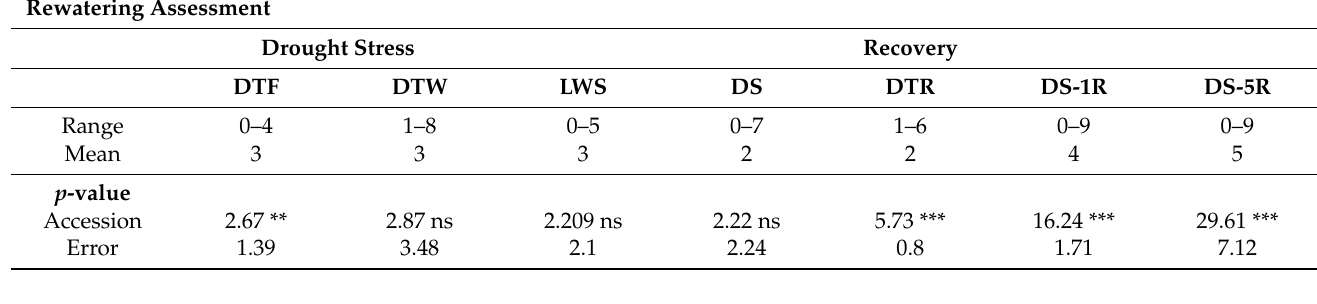
Table 6. Mean and the analysis of variance of days to the early panicle flowering (DTF), days to wilting (DTW), leaf wilting scoring (LWS), drought stress symptoms scoring (DS) and effects of rewatering on the days to recover (DTR) and DS at first and fifth day of recovery (DS-1R, DS-5R, respectively) in 44 A. tricolor accessions. Data represent range, mean, mean square with probability significantly different at p < 0.01 (**), p < 0.001 (***) or non-significant (ns) and mean square of error, n = 3.